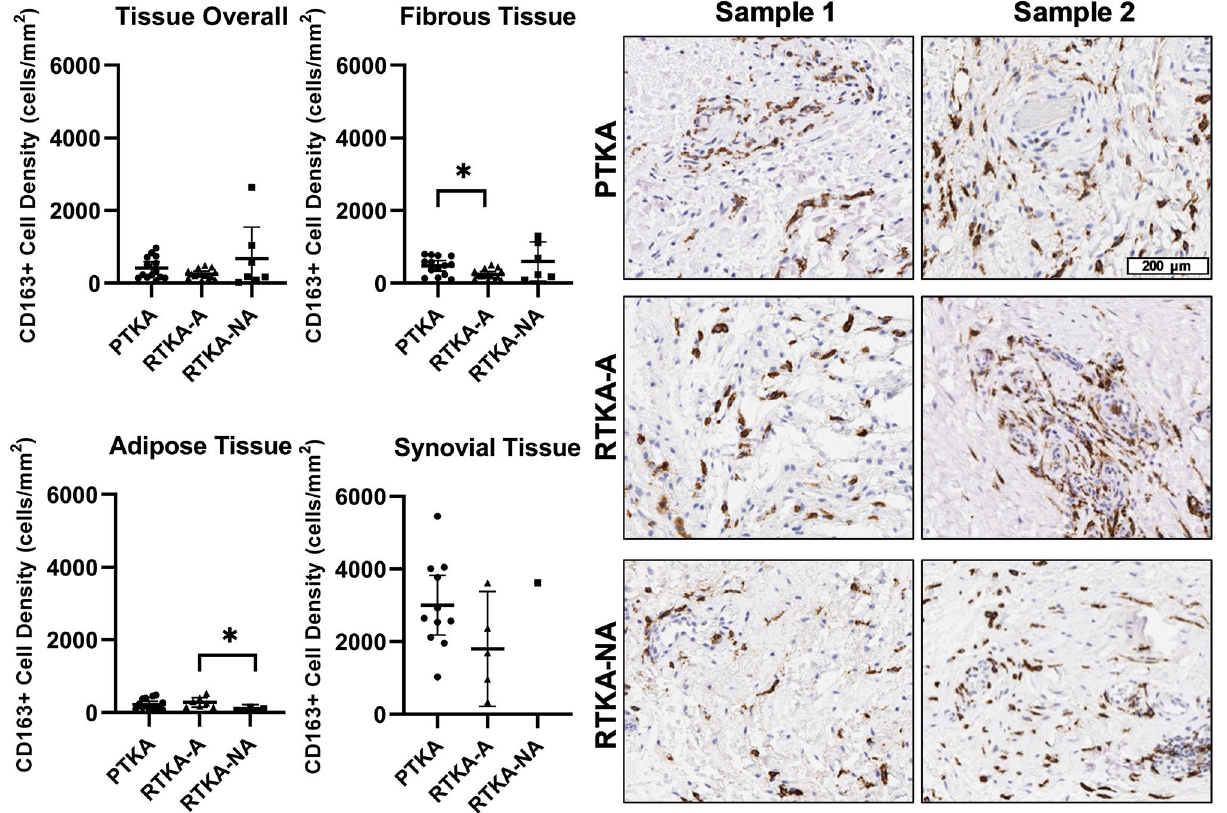
Figure 5. Quantification of macrophages in periarticular knee tissue. Tissue density of CD163 + macrophages per mm 2 in the overall tissue as well as the fibrotic, adipose, and synovium regions with representative images from the three groups ( PTKA = primary TKA, RTKA-A = arthrofibrosis, RTKA-NA = non-arthrofibrosis). The graphs depict mean macrophage density (CD163 + cell/mm 2 ) ± standard deviation, with each data point representing one patient. Asterisk denotes a significant difference, p ≤ 0.05, by the Wilcoxon Rank Sum test. Sample 1 and Sample 2 depict images from two different patients in the group. The scale bar applies to all images in this